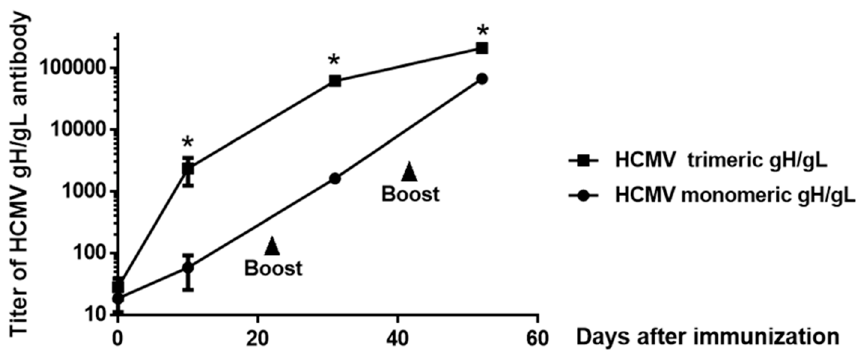
Figure 3. Serum titers of gH / gL-specific IgG following immunization with HCMV monomeric and trimeric gH / gL recombinant proteins. Groups of rabbits, 12–15 weeks old ( n = 5) were immunized subcutaneously with 25 µ g of HCMV monomeric versus trimeric gH / gL recombinant protein adjuvanted with alum + CpG-ODN, and boosted on days 21 and day 42 post-immunization. Sera were obtained 10 days following each immunization for the measurement of serum titers of gH / gL-specific IgG by ELISA. Significance * p < 0.05.